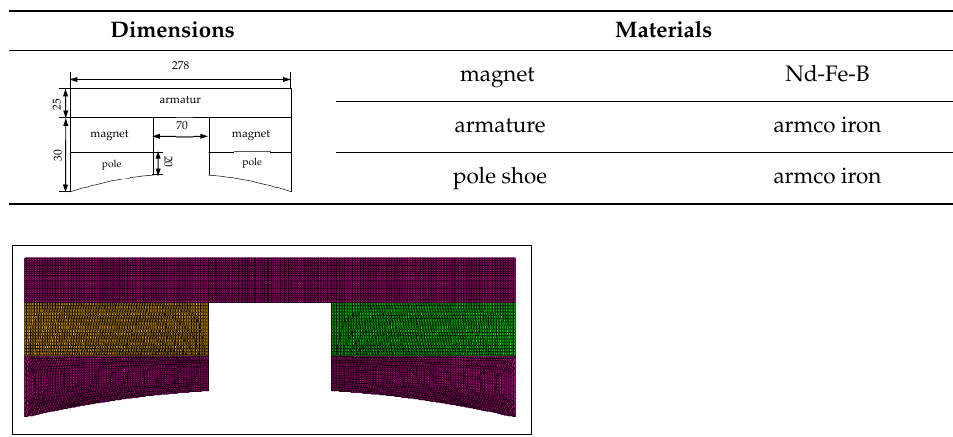
Figure 4. Crack reconstruction model under 18.8186 MPa load step. Figure 5. Diagram of pipeline weld and excitation structure. Table 3. Magnetized structural dimensions and materials. Figure 5. Diagram of pipeline weld and excitation structure. Figure 5. Diagram of pipeline weld and excitation structure. Table 3. Magnetized structural dimensions and materials. Table 3. Magnetized structural dimensions and materials. Figure 5. Diagram of pipeline weld and excitation structure. Figure 5. Diagram of pipeline weld and excitation structure. Table 3. Magnetized structural dimensions and materials. Table 3. Magnetized structural dimensions and materials.